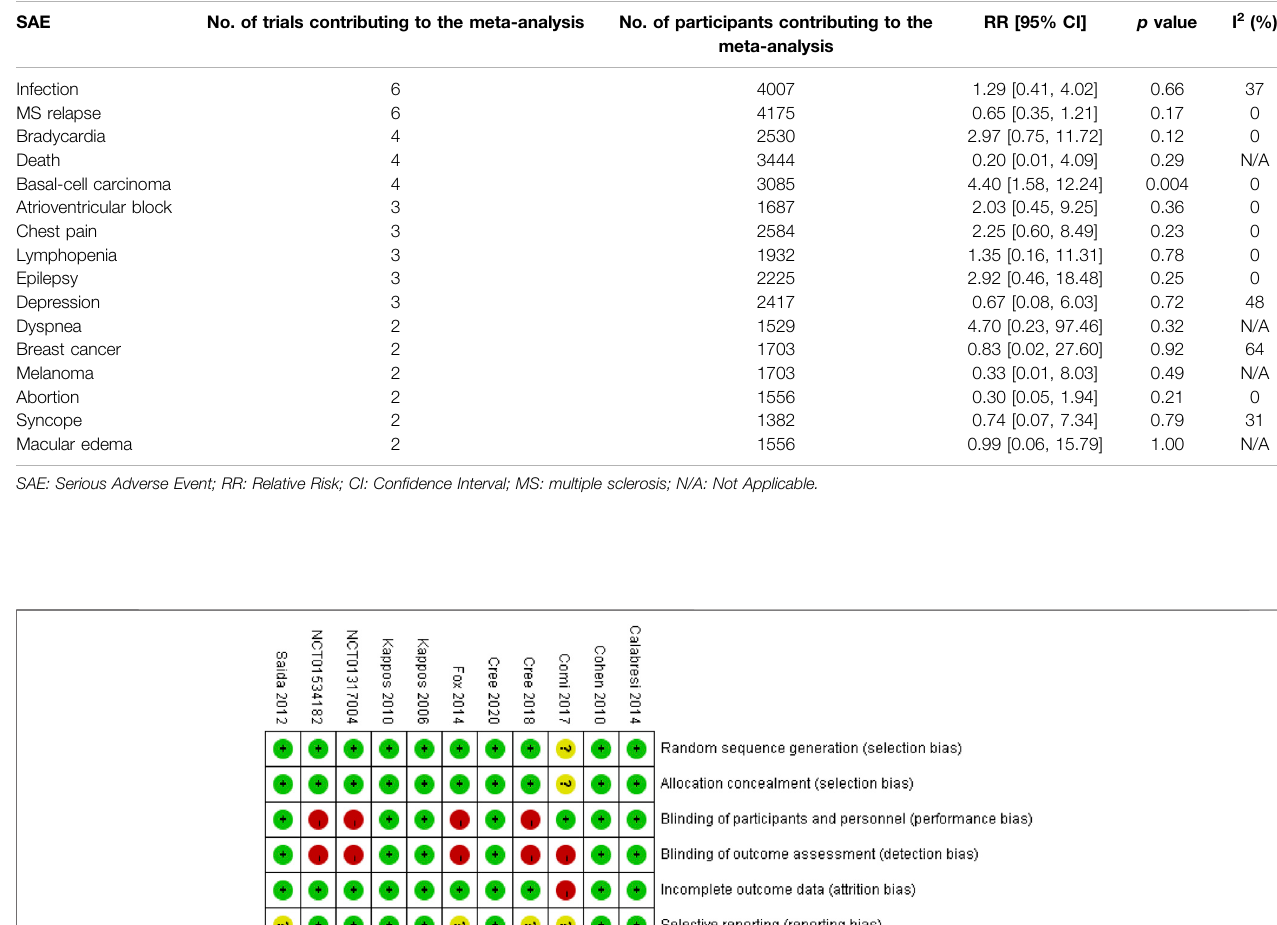
Frontiers in Pharmacology |